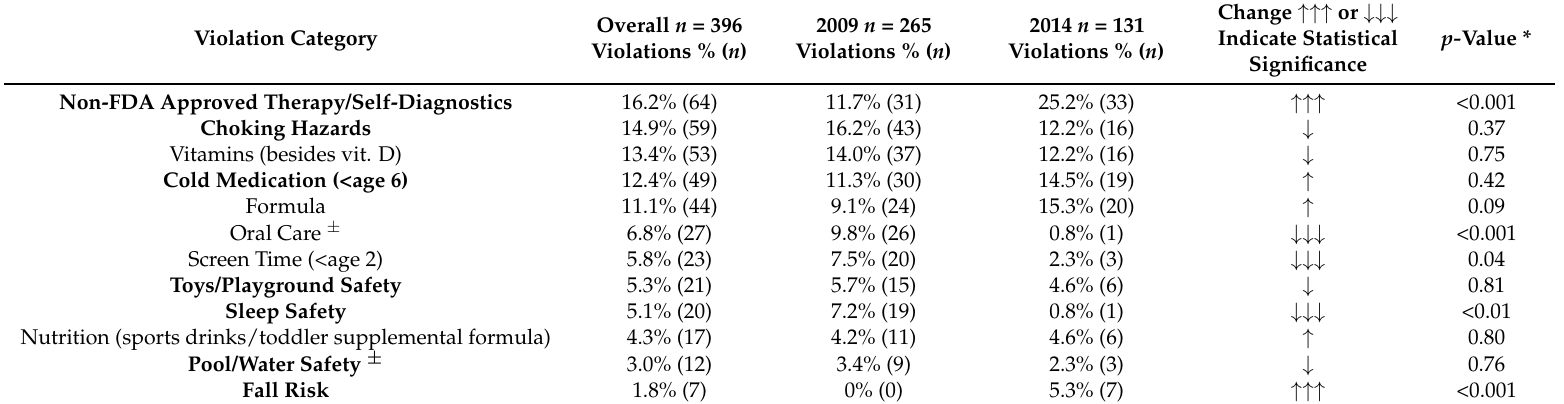
Table 2. Comparison of categories of non-adherence of AAP recommendations in advertisements in top two parenting magazines over five